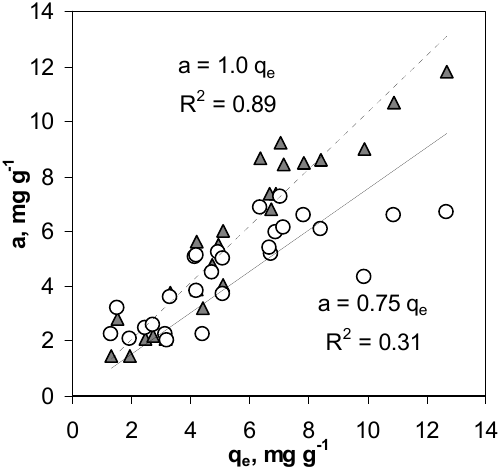
Figure 12. As(V) adsorption estimated from kinetic curves (q e ) and from adsorption isotherms (a) at the same equilibrium concentrations. Triangles: a values linearly interpolated from the isotherms (linear regression—dashed); circles: a values calculated from the Langmuir adsorption equation (linear regression—solid).